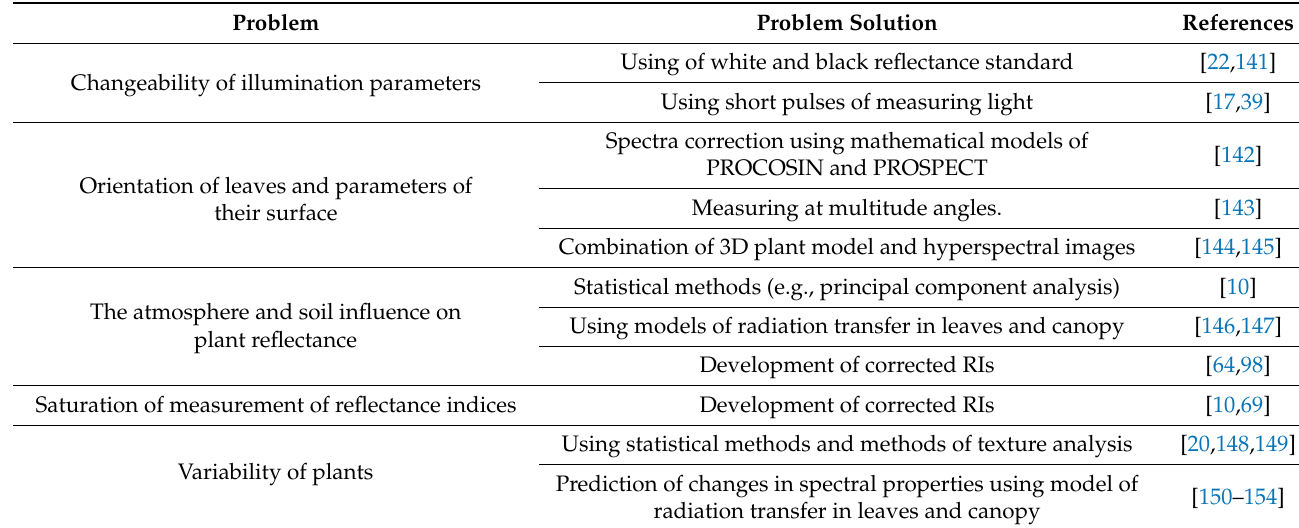
Table 2. Some problems of measurement and analysis of reflectance